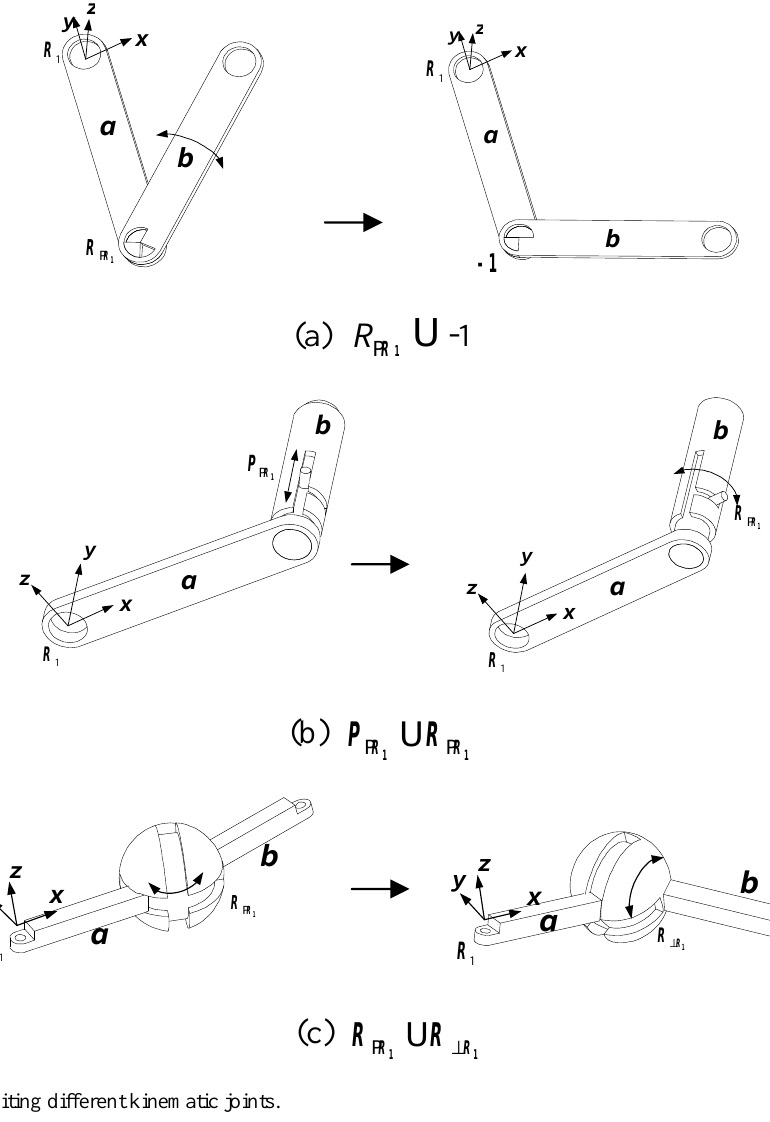
Figure 2. The result of uniting different kinematic joints. + 1 ,m ) equal, the corresponding element in matrix A ( m var is as- signed the number 0. Conversely, the elements in the minu- end matrix are reserved directly, and the principal diagonal elements remain unchanged for recognition purposes. The same rule is used for the lower off-diagonal elements. If an upper off-diagonal element is unchanged, the corresponding lower off-diagonal element needs to be assigned the value 0 regardless of its actual value. The joint variation matrix can